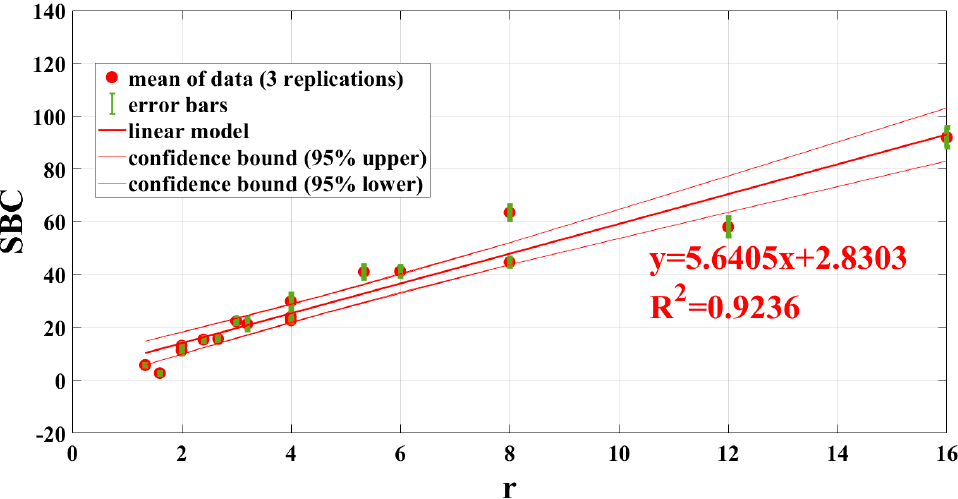
Figure 14. SBC versus r for TSR 2nd derivative 256 frames, error bands and confidence bounds on the find linear model.